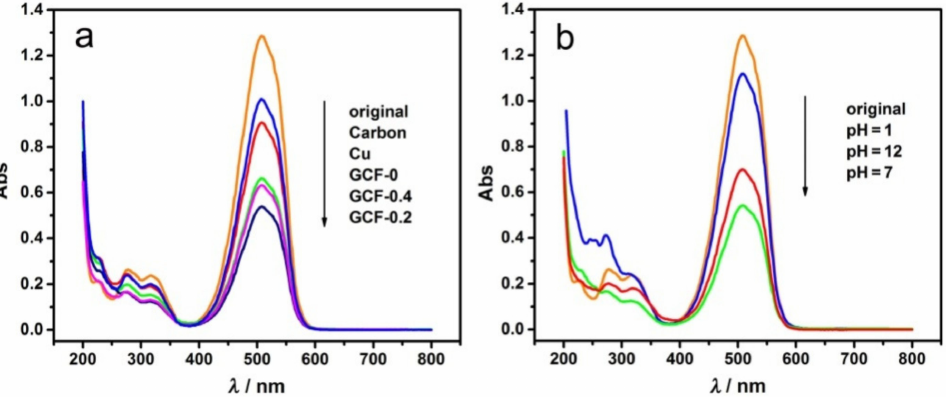
Figure 4. UV–visible absorption spectra of MO before and after decolorization: ( a ) different samples; ( b ) different pH values with GCF-0.2.